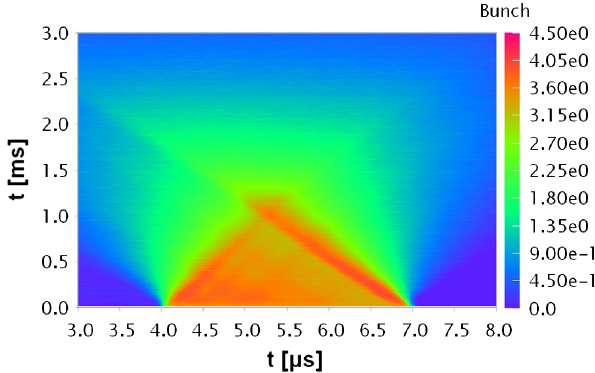
FIG. 33. Mountain view for a 100 (cid:1) A beam bunch signal.